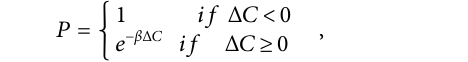
Frontiers in Molecular Biosciences |